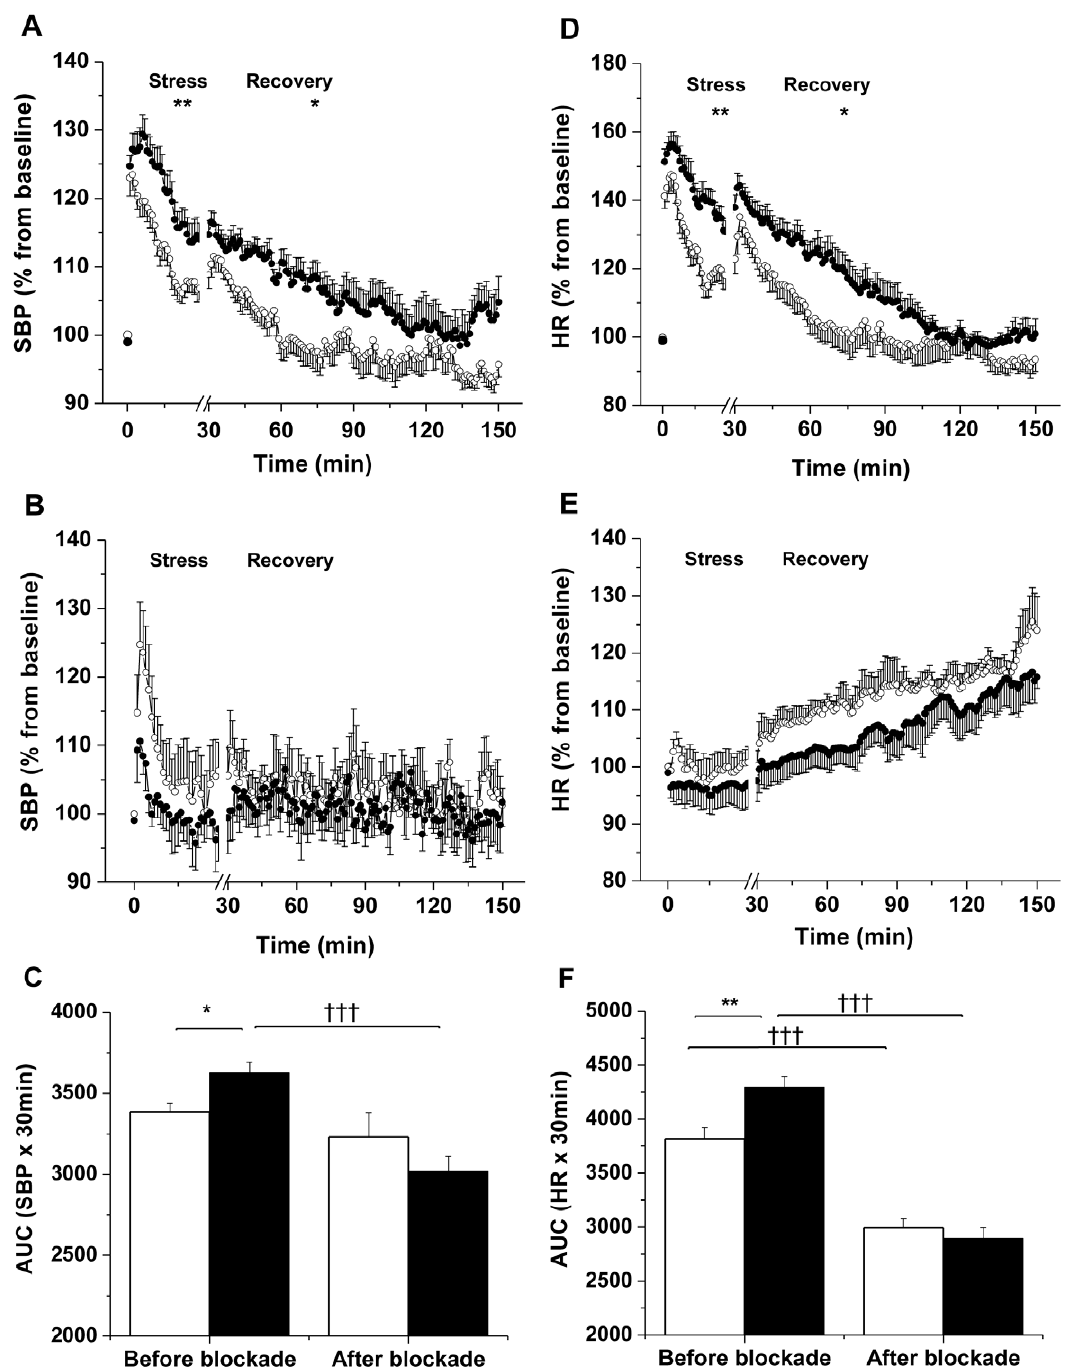
Figure 2. Male offspring of fat-fed dams had an increased pressor and chronotropic response during acute stress. (A, B) SBP and (D, E) HR responses during 30 min of acute stress and 120 min of recovery, before (A, D) and after adrenergic receptor blockade (B, E) in male offspring born to dams fed a control (open circles) or a fat diet (closed circles), n=11 per group before blockade; n=5 per group after blockade. *P # 0.05, **P # 0.01 versus control. (C) Area under the curve (AUC) for SBP and (F) HR during stress before and after blockade in male offspring born to dams fed a control (unfilled bars) or a fat diet (filled bars), n=11 per group before blockade; n=5 per group after blockade. *P # 0.05, **P # 0.01 versus control. {{{ P # 0.001 versus before blockade. Error bars represent mean 6 SEM. doi:10.1371/journal.pone.0025250.g002 r 2 = 0.287 (95% CI for r 2 0.022 to 0.610), p = 0.010 n =22).